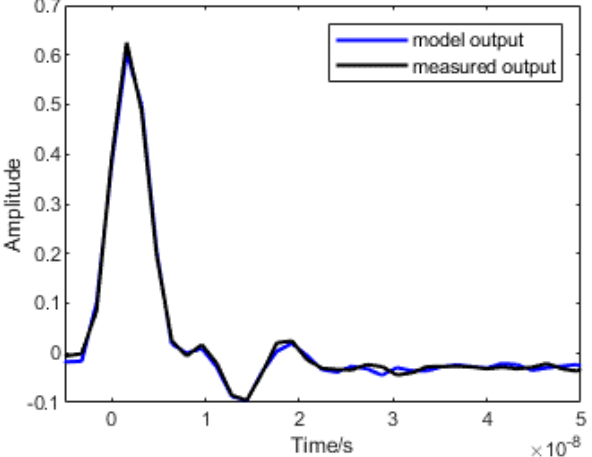
Figure 6. The verification of the output error model. Where the blue line refers to the model output, the black line refers to measurement output.